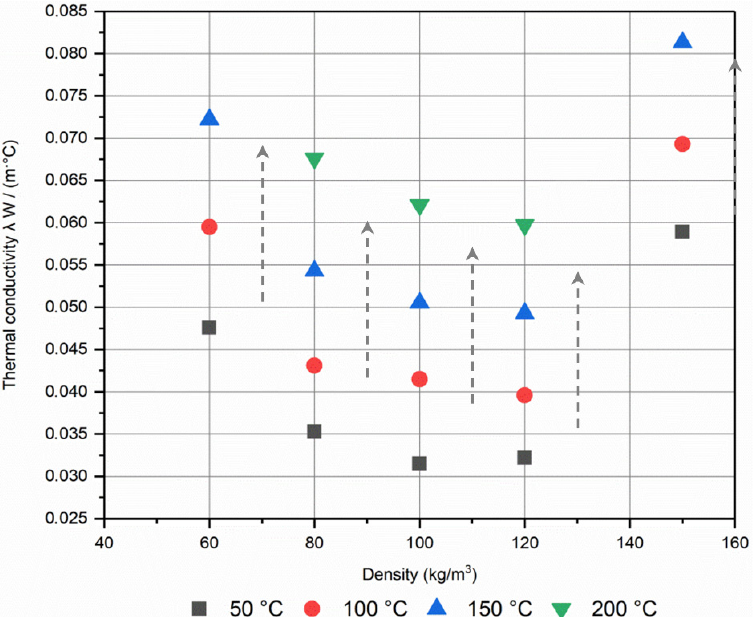
Figure 2. The thermal conductivity of the thermal insulation material made of basalt fibre as a function of density and the average temperature of the thermal insulation layer (50, 100, 150, and 200 ◦ ° С ).